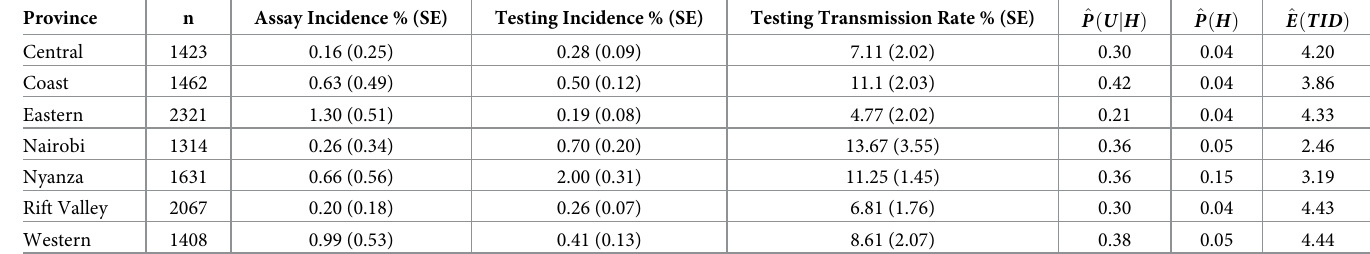
Table 4. Incidence results for KAIS 2012 by province (Northeastern province excluded from the sample frame due to regional insecurity).